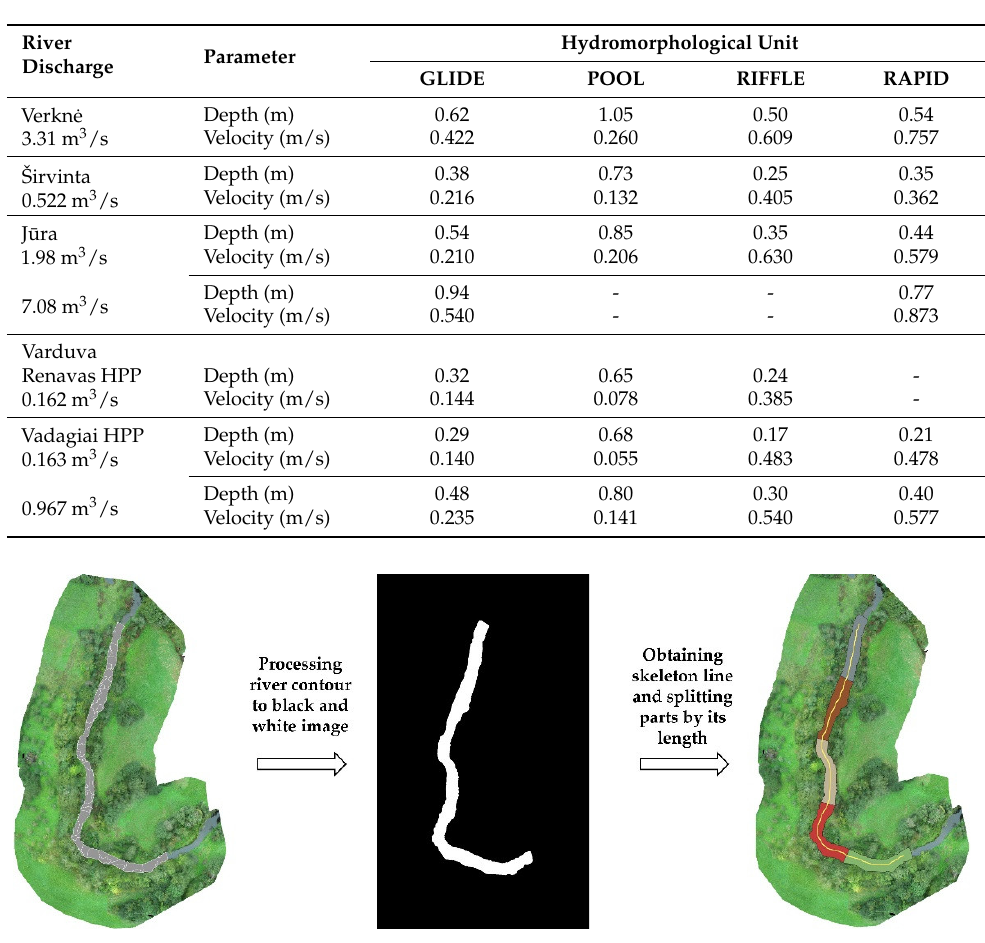
Figure 6. The scheme of data preparation for cross validation (the Verknė River example). Different river segments were used in boulder detection and HMU segmentation models for training and validation. An overview of the generalized data of HMU areas and the number of boulders in each fold is provided in Table 3. Table 3. Composition of folds according to the mean of HMU area, number of HMU polygons and number of boulders.